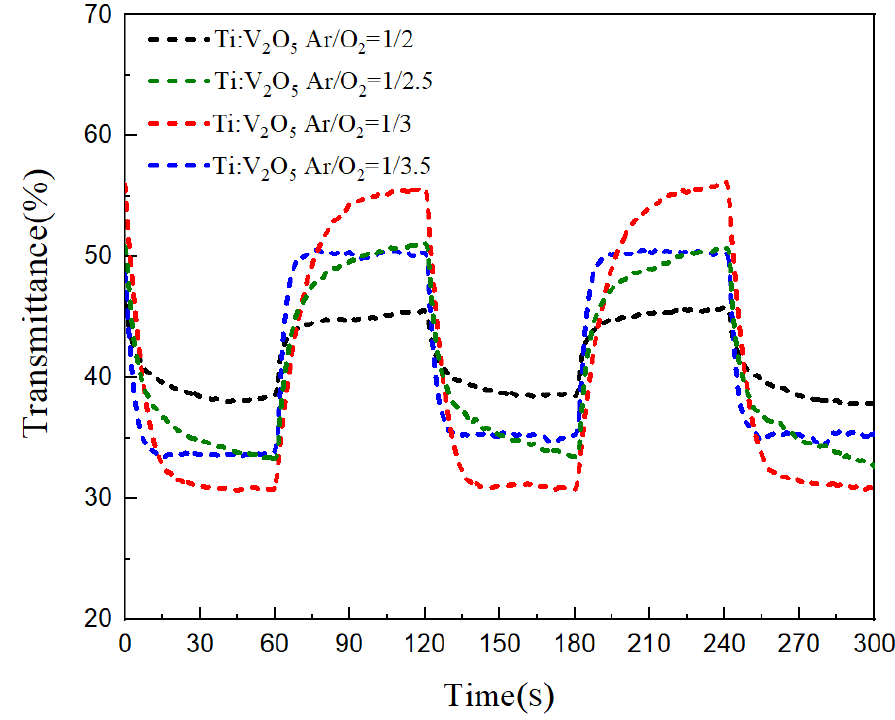
Figure 4. In situ optical transmittance response at 633 nm of Ti:V 2 O 5 electrode films with various Ar/O 2 gas flow ratios.